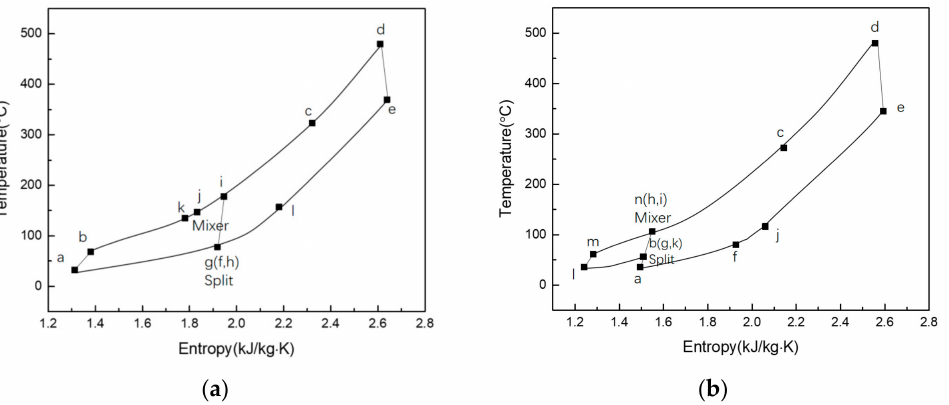
Figure 6. T - s diagram at the optimum point with the advanced cycles. ( a ) Recompression cycle, ( b ) partial cooling cycle. a–n represent state points of working fluid in the cycle.